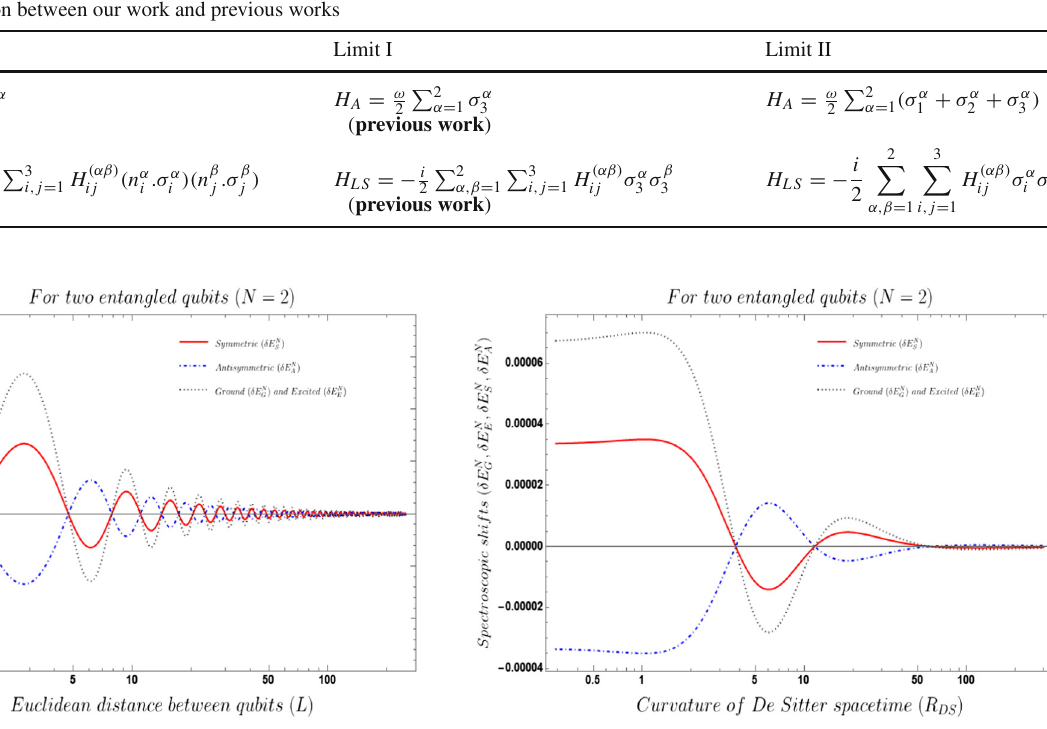
Fig. 3 Behaviour of spectroscopic shifts wrt the curvature of the De- Sitter spacetime. The other parameters are kept fixed ( ω = 1 , L = 1 ,μ = 0 . 1 ,ω 0 =